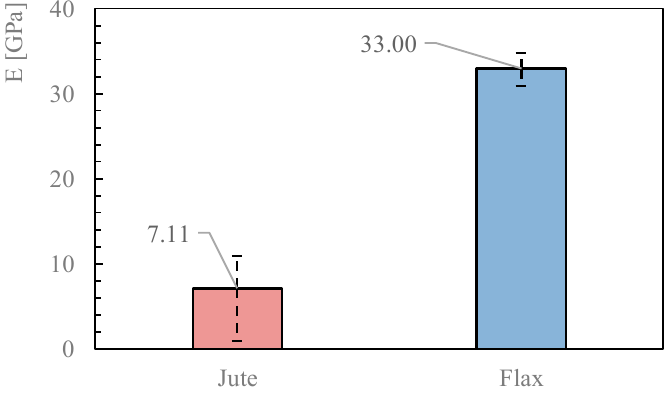
Figure 11. Mean value for Young’s modulus.